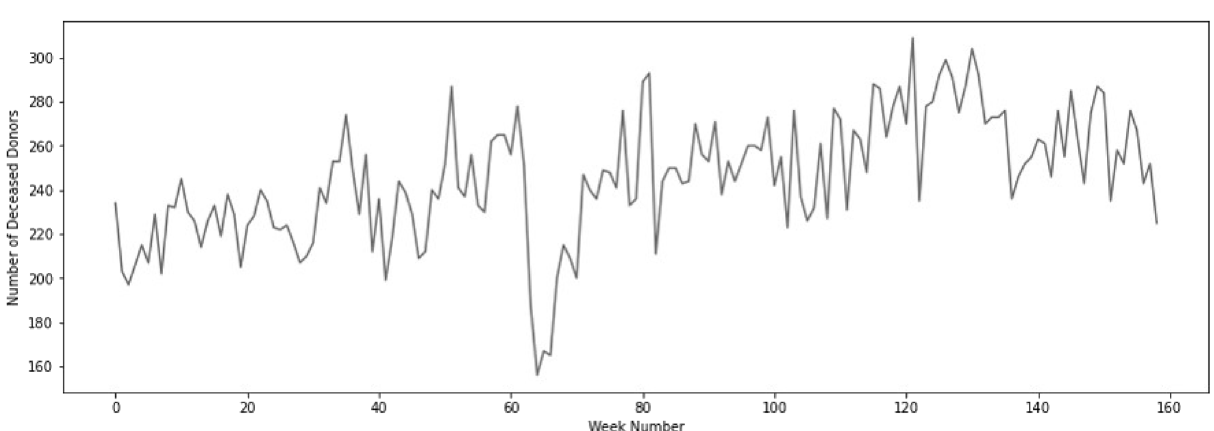
Figure 2. Number of USA deceased organ donors weekly, beginning of 2019 until week 3 in 2022.